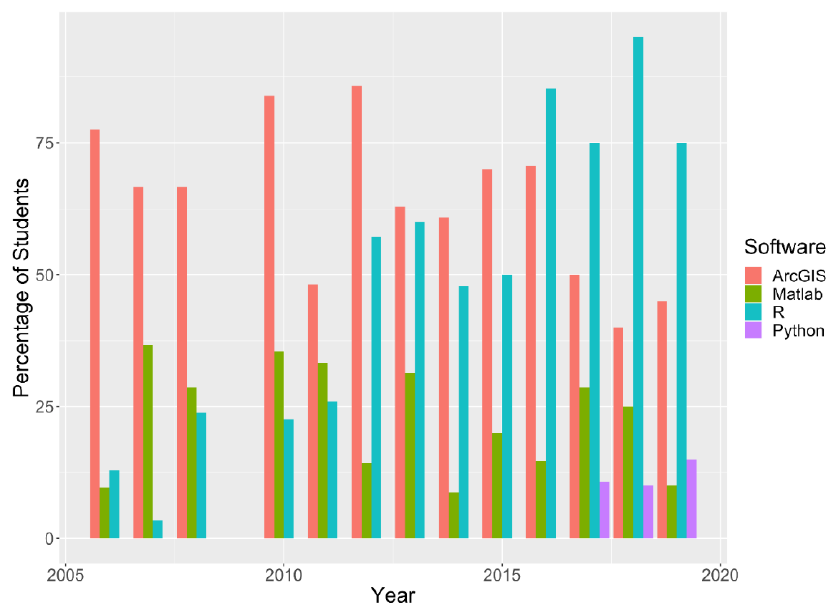
Figure 3. Software utilization of course participants prior to the course, as indicated on their course registration form. Since many participants use more than one software package the percentages for a given year will exceed 100%.